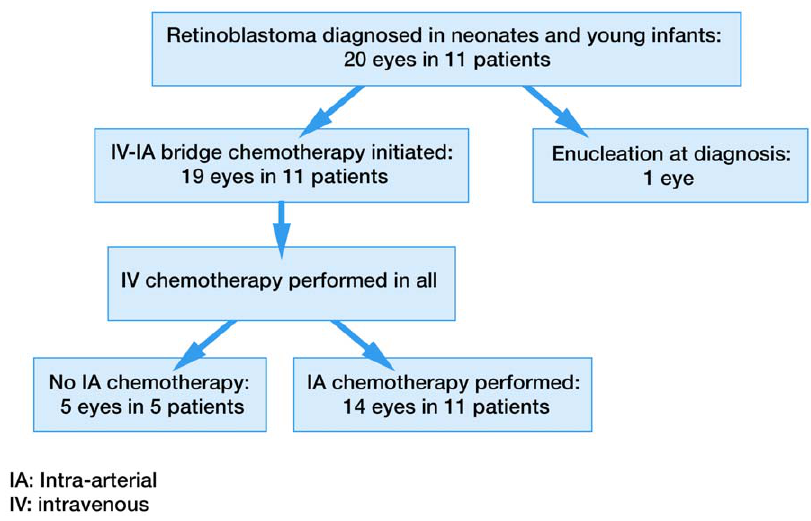
Figure 1. Treatment flow of Bridge IV-IA chemotherapy.